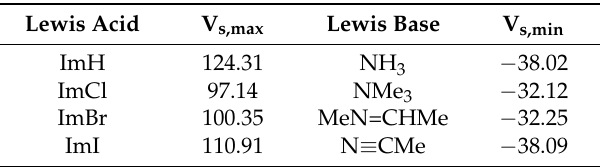
Table 6. V s,max and V s,min (kcal/mol) for Lewis acids and bases, respectively, on isopotential surface corresponding to ρ = 0.001 au.